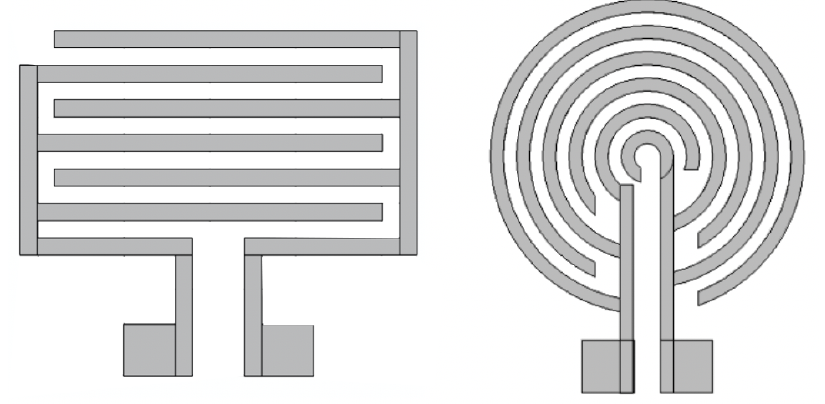
Figure 1. Electrode designs: rectangular IDE ( Left ), circular IDE ( Right ).